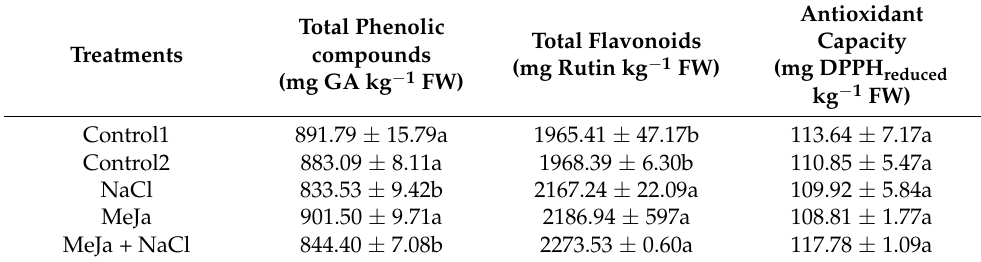
Table 6. The content of total phenolic compounds (mg GA kg − 1 FW), total flavonoids (mg Rutin kg − 1 FW), and antioxidant capacity (mg DPPH reduced kg − 1 FW) in the leaf tissues of C. maritimum under the different treatments (Control1, Control2, NaCl, MeJa, NaCl + MeJa), ( n = 10). Columns with different letters (a, b) for each variable differ significantly according to Tukey’s test ( p < 0.05).